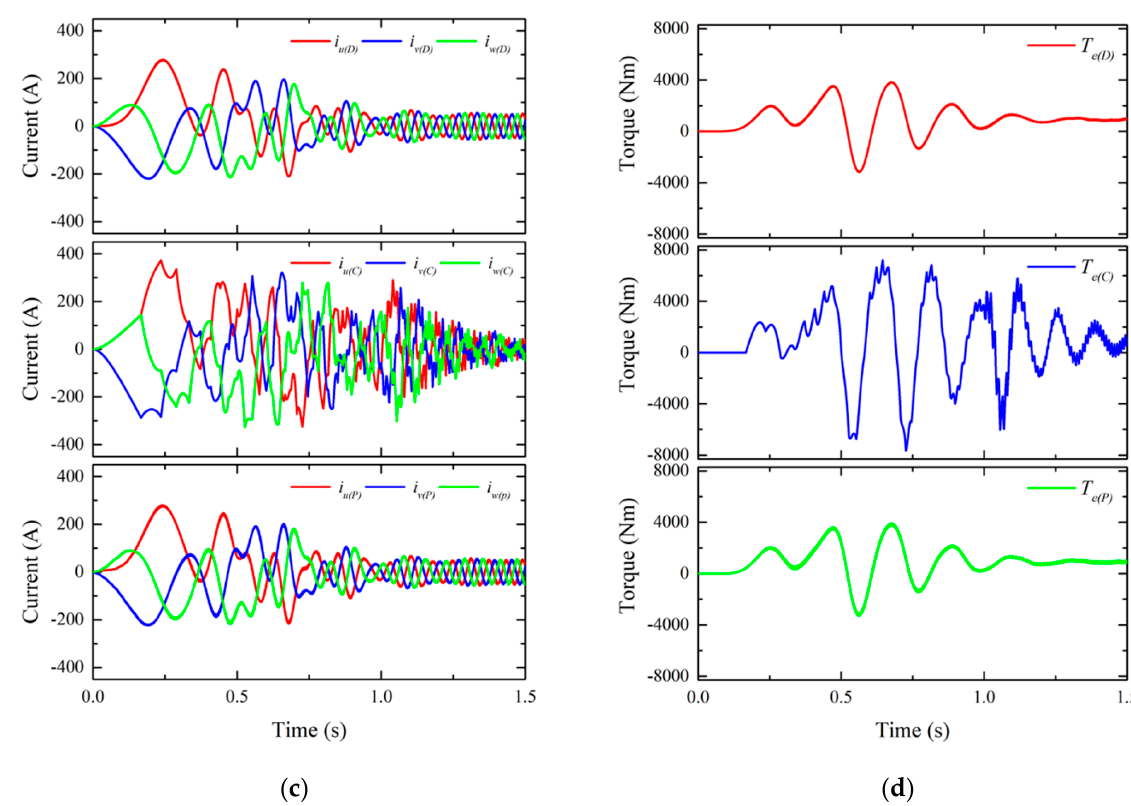
Figure 3. Comparison of dynamic characteristics at initial startup of EMDS. ( a ) Phase u voltage; ( b ) Motor speed; ( c ) Three phase currents; ( d ) Output torque.